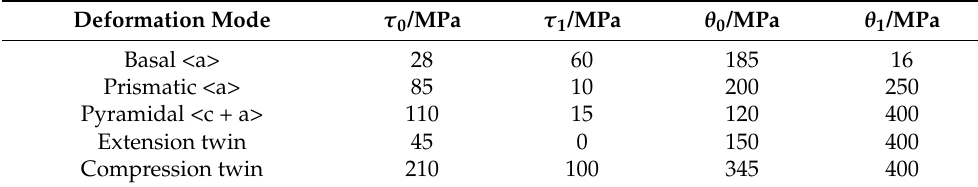
Table 1. Hardening parameters of each slip and twinning system in the simulation of Mg alloy under monotonic loading.